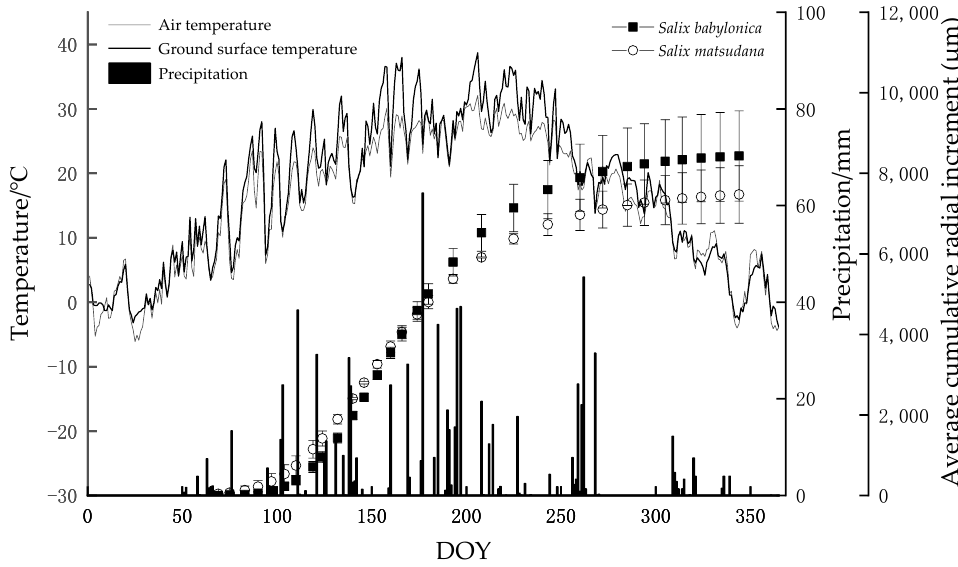
Figure 5. Intra-annual xylem growth of Salix babylonica and Salix matsudana fitted by Gompertz function and the corresponding main climatic factors during 2018 growing season.